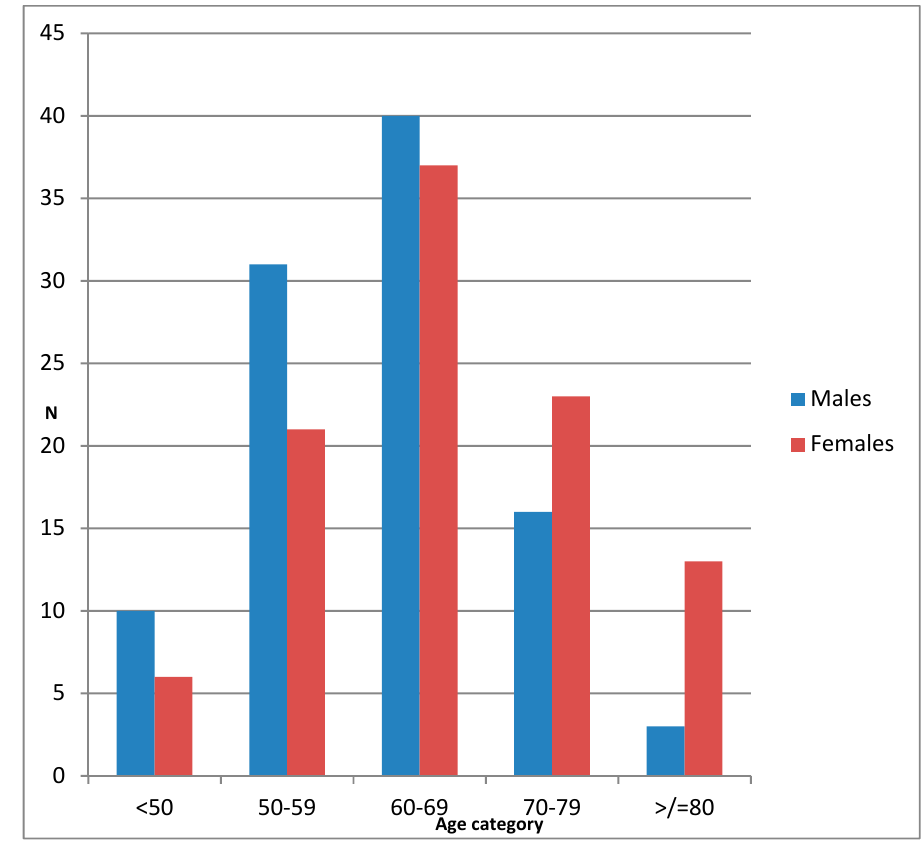
Figure 1. Age distribution of patients according to gender.